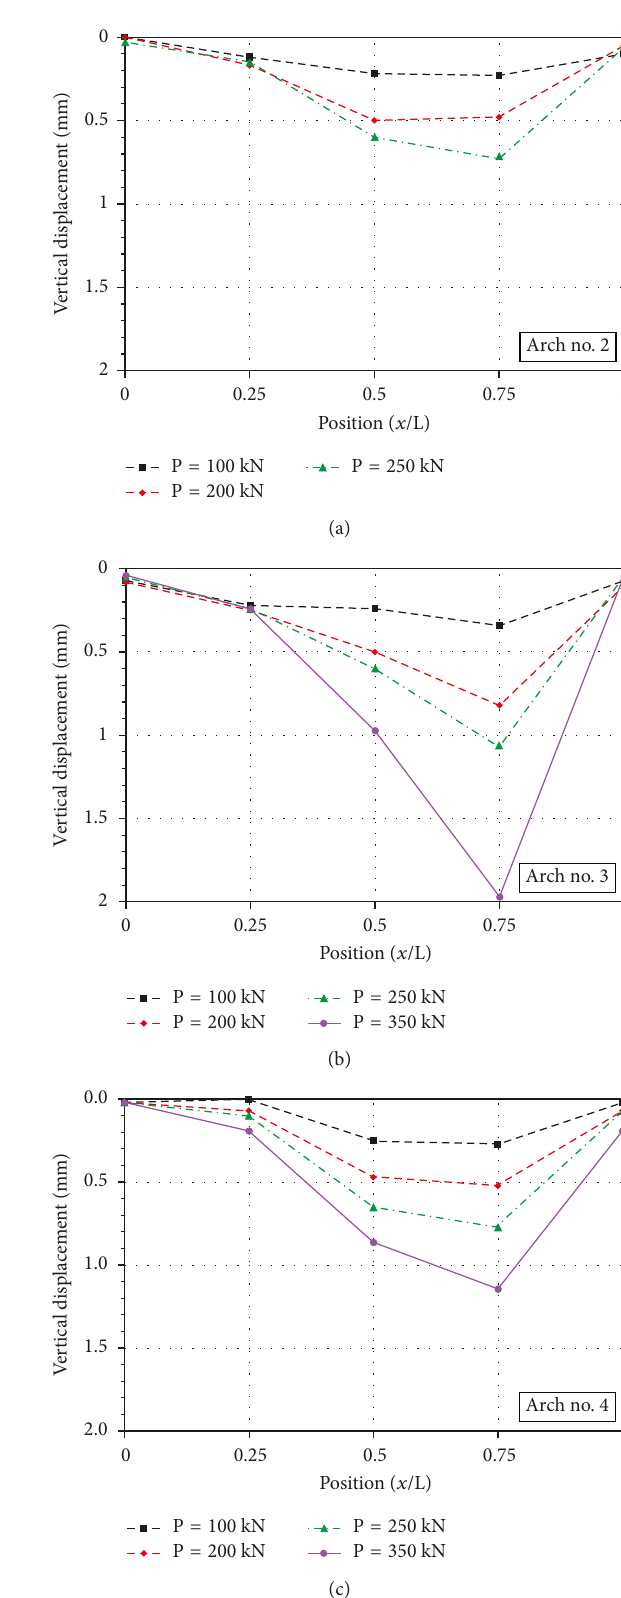
Figure 11: Test on arches subject to static asymmetric loading: (a)–(c) vertical displacements obtained by optical level for the three arches